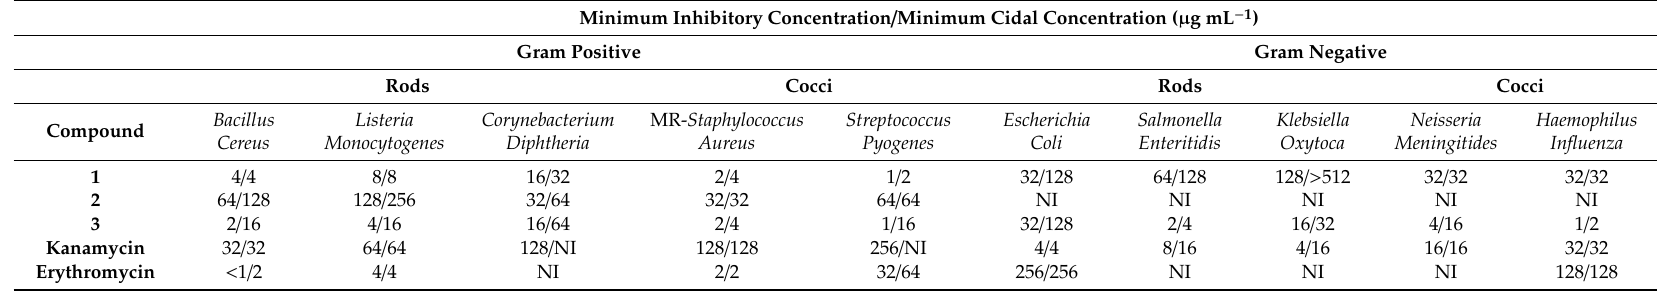
Table 3. Antibacterial activity of compounds isolated from Pseudomonas aeruginosa